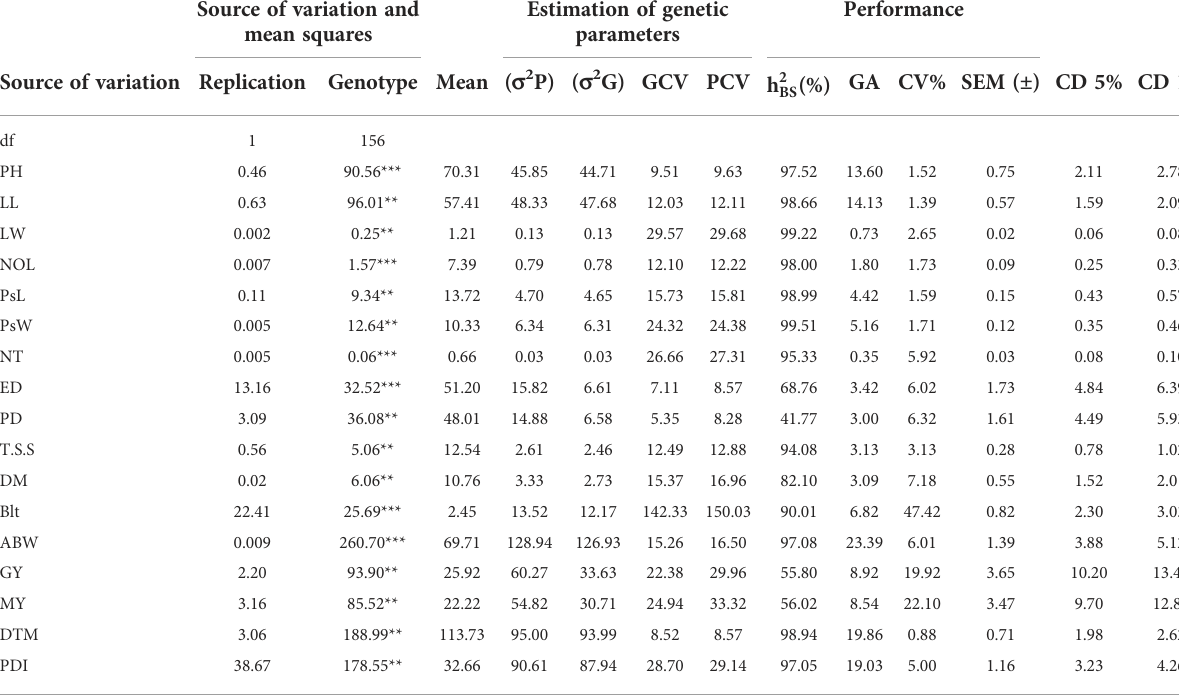
TABLE 2 Genetic variability of 16 morphological and two biochemical traits of onion genotypes. Source of variation and Estimation of genetic mean squares parameters